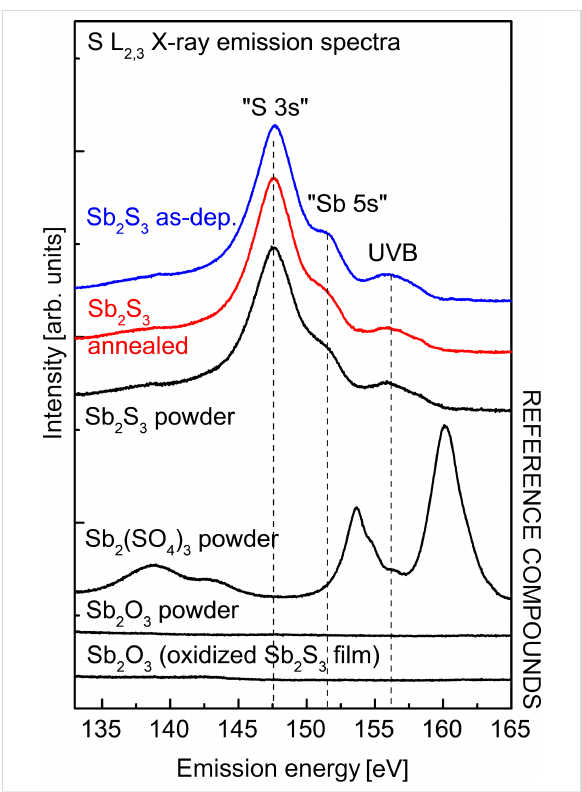
Figure 2: S L 2,3 XES spectra of two Sb 2 S 3 films, as-deposited (“as- dep.”, blue) and after post-deposition treatment (“annealed”, red), both on a glass/ITO/TiO 2 underlay (excitation energy 180 eV). Peaks corre- sponding to electronic transitions from valence states with strong S 3s and Sb 5s contributions into the S L 2,3 core holes of the XES initial state, and transitions from the upper valence band (UVB) are indicat-